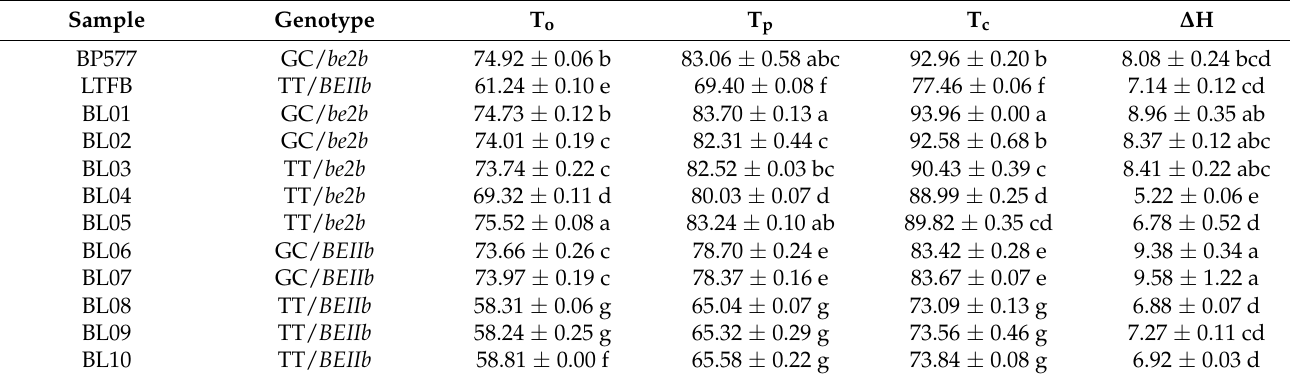
Table 4. Thermal properties of rice